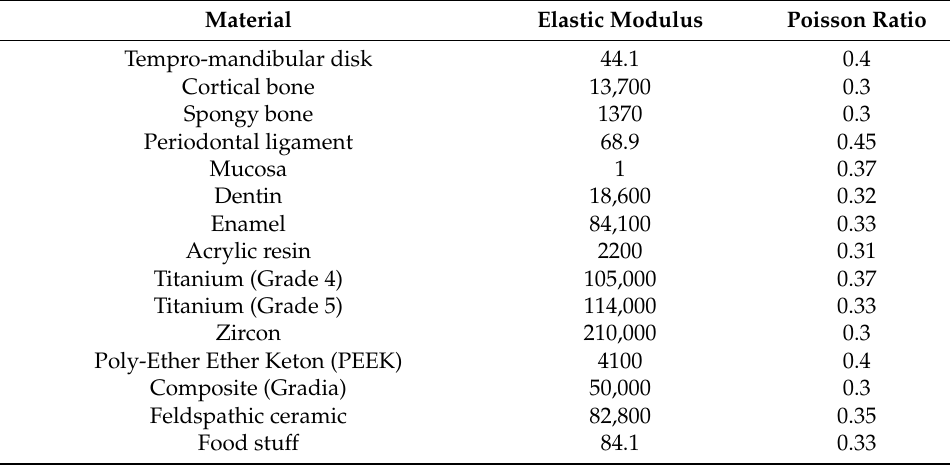
Table 1. Element and node numbers of maxillary and mandibular models.